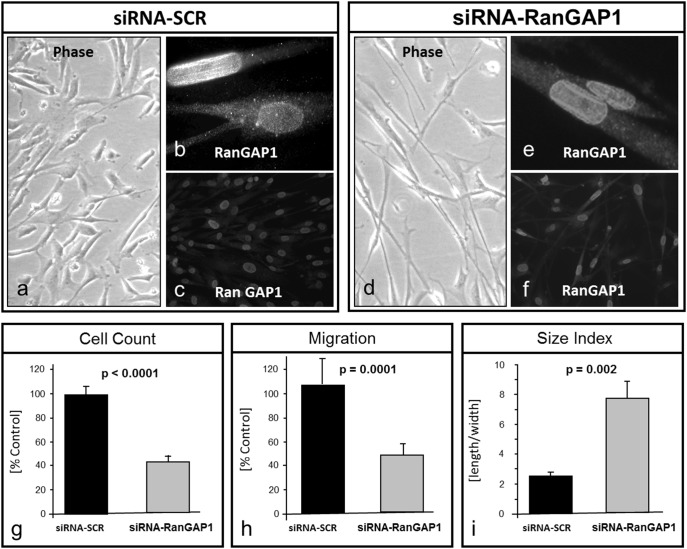
Gene silencing of RanGAP1 by siRNA in CASMC.CASMC fixed and permeabilized with 4% PFA and 0.2% Triton X-100 were subjected to indirect immunofluorescence with an RanGAP1 antibody. CASMC treated with control scrambled siRNA reveal accumulation of RanGAP1 expression at the nuclear rim rather than in the cytosol (a–c). Likewise, siRNA-RanGAP1 mediated gene silenced CASMC show a residual RanGAP1 expression mainly at the nuclear rim (d–f). Gene silencing of RanGAP1 by means of specific siRNA transfection lead to inhibition of proliferation by 57.4±4.8% (p<0.0001) (g). Similarly, mitogen-induced CASMC migration was sharply inhibited by 48±9% in RanGAP1 siRNA transfected cells (p = 0.0001) (h). Concomitantly, the phenotype of siRNA RanGAP1 treated CASMC showed a significant difference in the cellular size index (length/width; 7.8±2.5 vs. 2.5±0.9 p = 0.002) (i), indicating a phenotypic change that is consistent with contractile, quiescent CASMC.